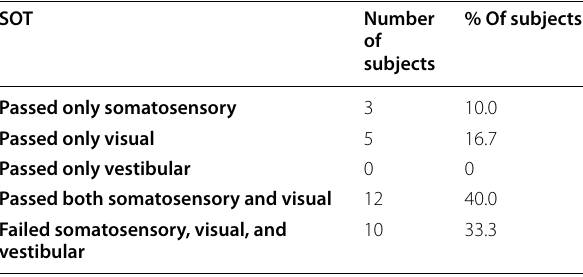
Table 5 Distribution of the studied cases according to sensory